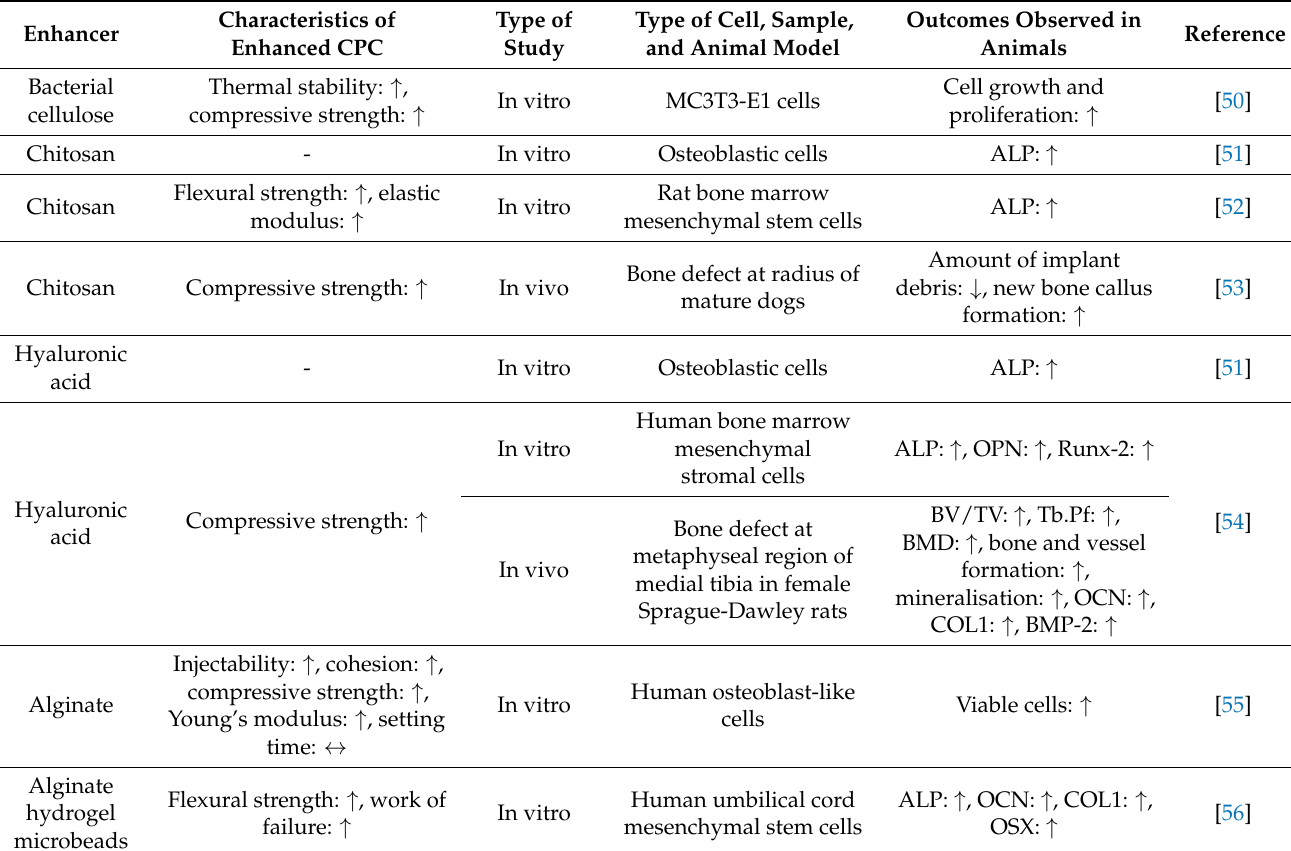
Table 4. The bone protecting effects of CPC enhanced by